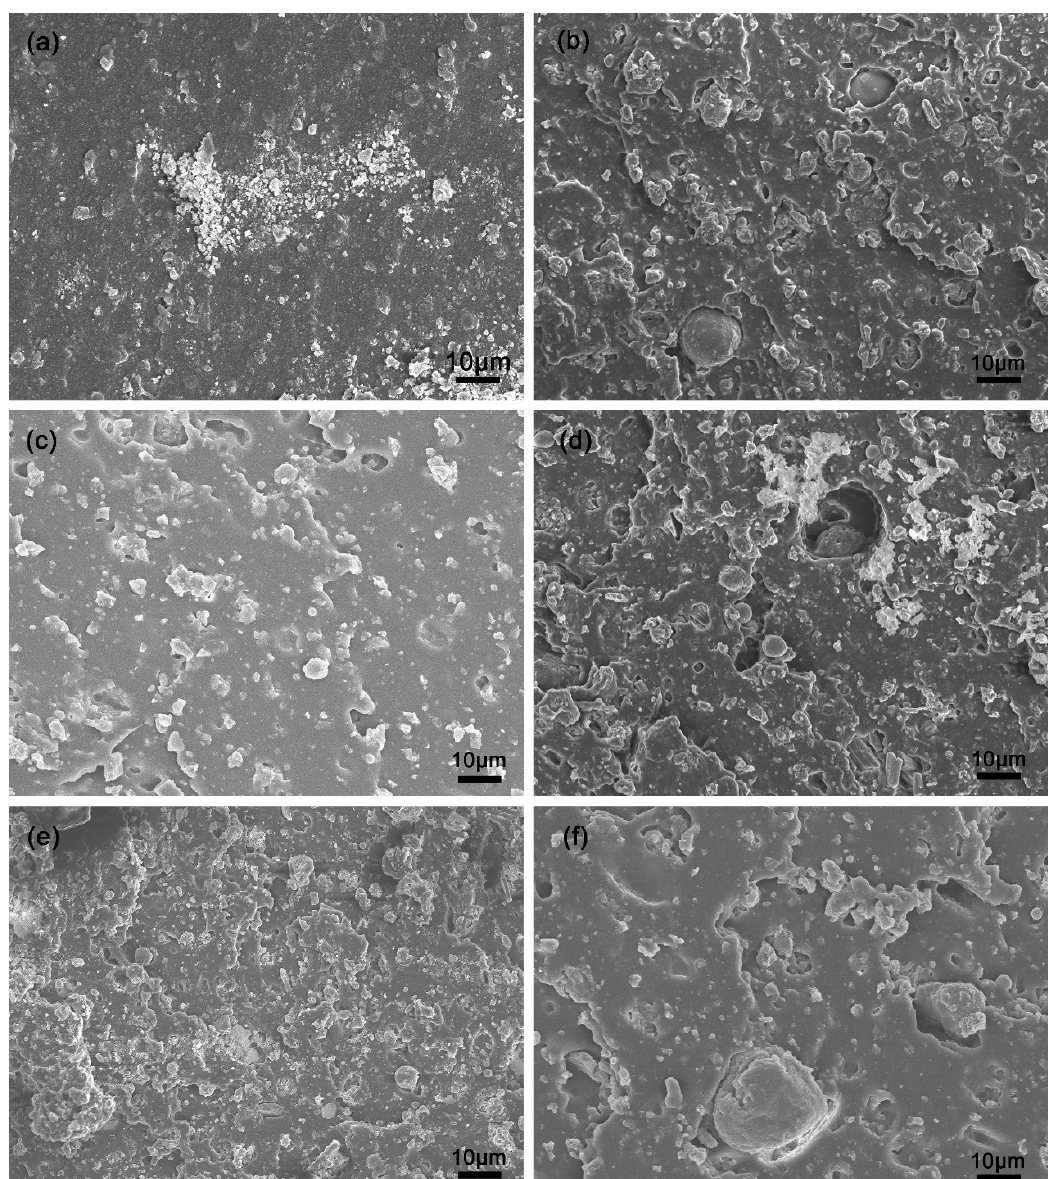
Figure 8. SEM showing the tensile fracture surfaces of the SBR composites filled with P-silica and FS-SiO 2 , ( a ) SBR-P-Silica, ( b ) SBR-FS-5.3, ( c ) SBR-FS-6.3, ( d ) SBR-FS-7.3, ( e ) SBR-FS-8.3, ( f ) SBR-FS-9.3.